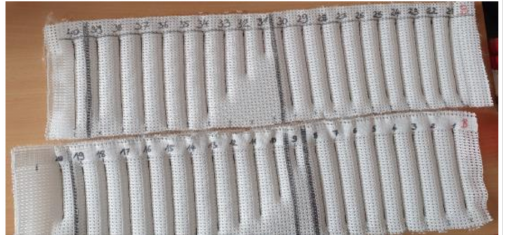
Figure 10. Warp knitted fabric with seams of different 3D sewing parameters of quilt stitches (TU-Dresden).